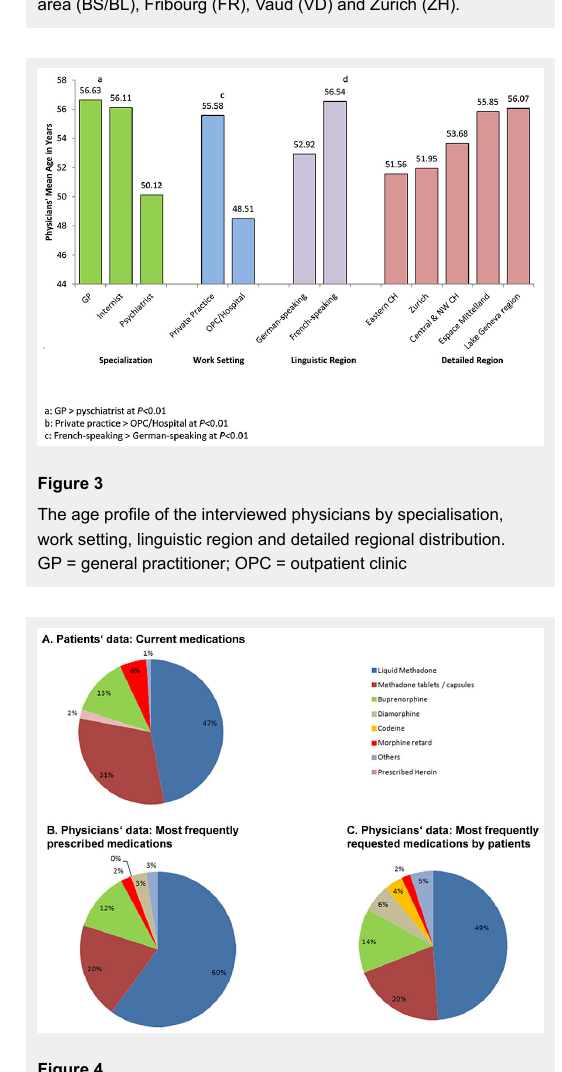
A summary of opioid maintenance therapy medication choices in Switzerland. A. Patients’ current medication. B. Most frequently prescribed medications. C. Medications most frequently requested by patients, as reported by